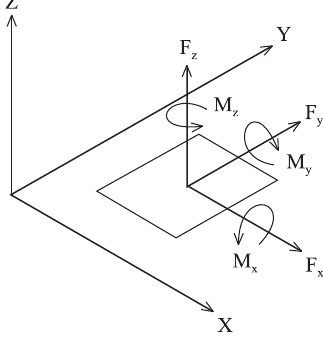
Fig. 1. Example of a Kistler force plate design [6]. Fig. 2. Three-axial orthogonal force plate coordinate system and associated force and moment components (after Caldwell et al. [5]).